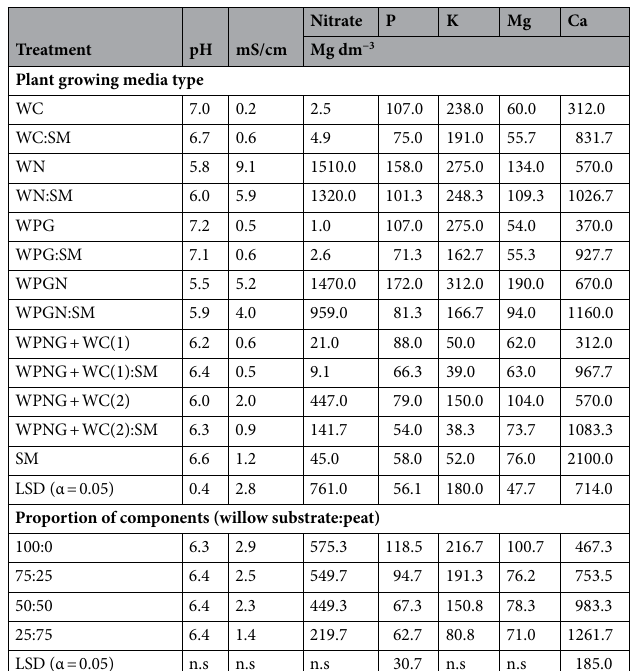
Table 4. Horticulture media chemical composition—tomato.